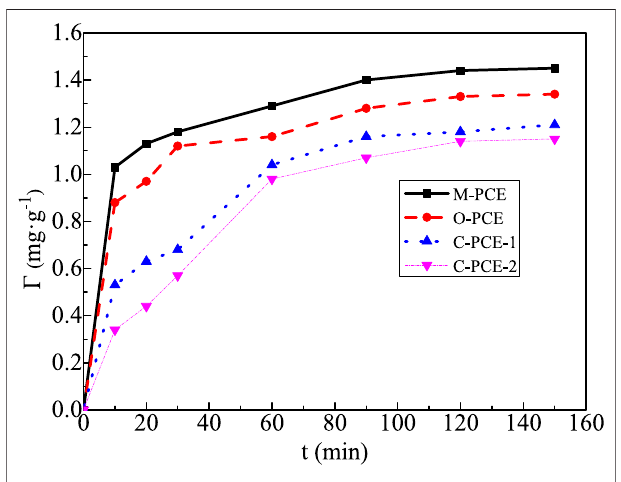
FIGURE 8 | Lagergren fi tted line of adsorption rate equation of polycarboxylate at cement particle surfaces (20 ° C).